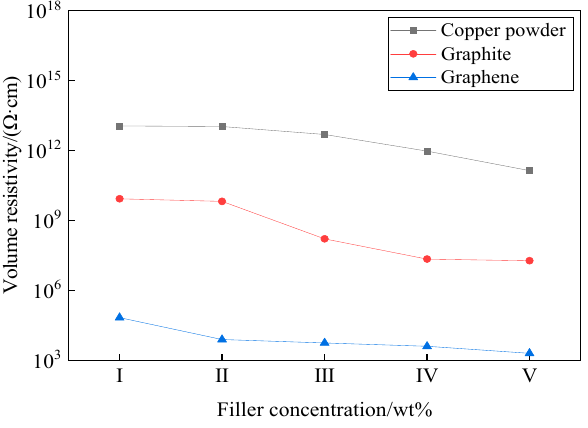
Figure 9. Volume resistivity–filler concentration relationship.